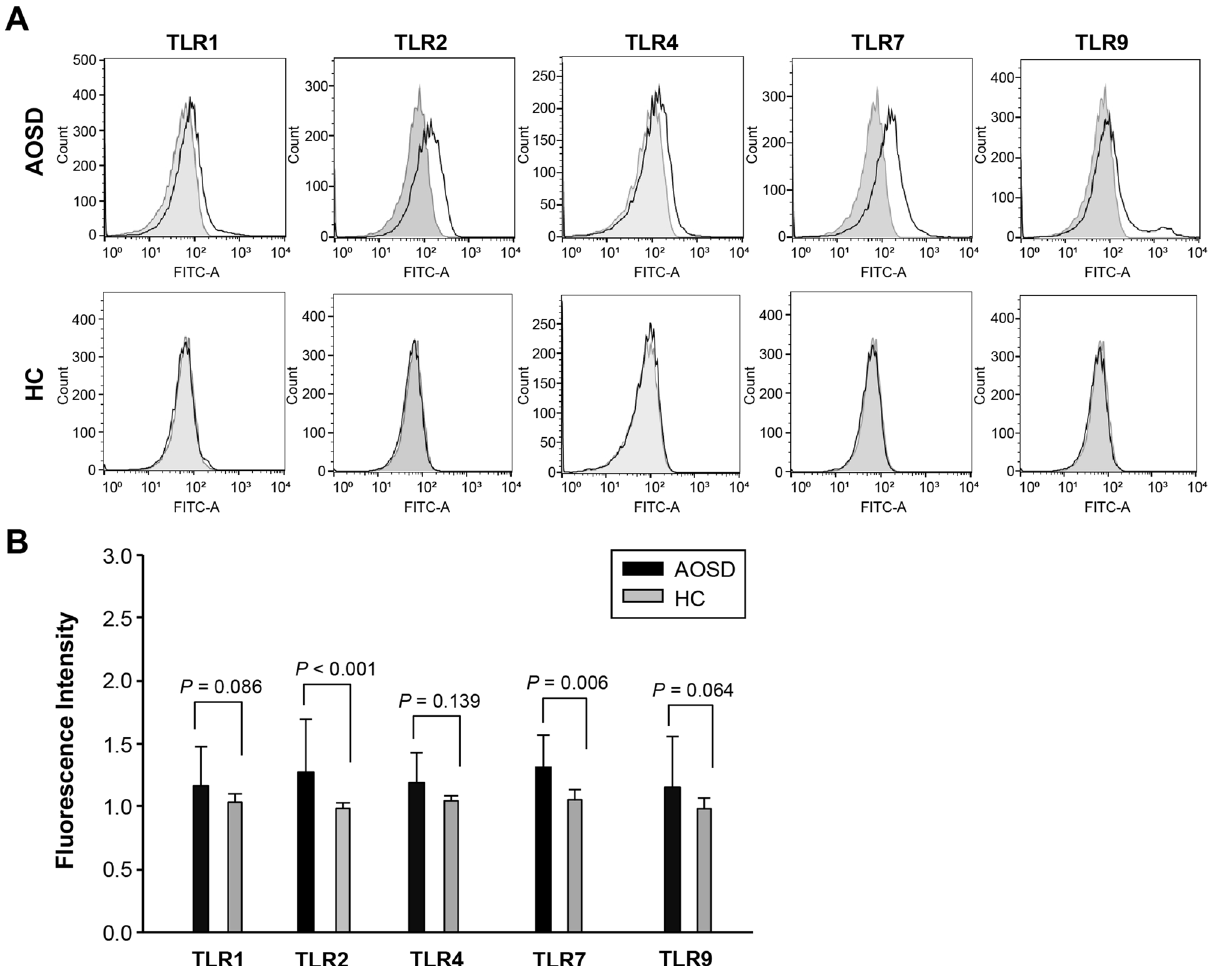
Figure 2. ( A ) Representative flow cytometric histograms of stained cells presenting toll-like receptor (TLR) from peripheral blood of one patient with adult-onset Still’s disease (AOSD) and a healthy control (HC) are shown. ( B ) Flow cytometric results of the percentage of surface-stained cells presenting TLR1, TLR2, TLR4, TLR7, and TLR9 in patients with AOSD and HC. Results were obtained from 20 patients with AOSD and 15 HCs. The bar with horizontal line indicates the mean value with standard deviation for each group. The p-value was determined using the Mann–Whitney U -test. Significantly higher mean intensity of stained cells presenting TLR2 was observed in patients with AOSD than in HC (p < 0.001). A significantly higher intensity of cells presenting TLR7 from whole blood was seen in patients with AOSD than in HC (p = 0.006). However, there was no significant difference in the intensity of cells presenting TLR1, TLR4, or TLR9 between patients with AOSD and